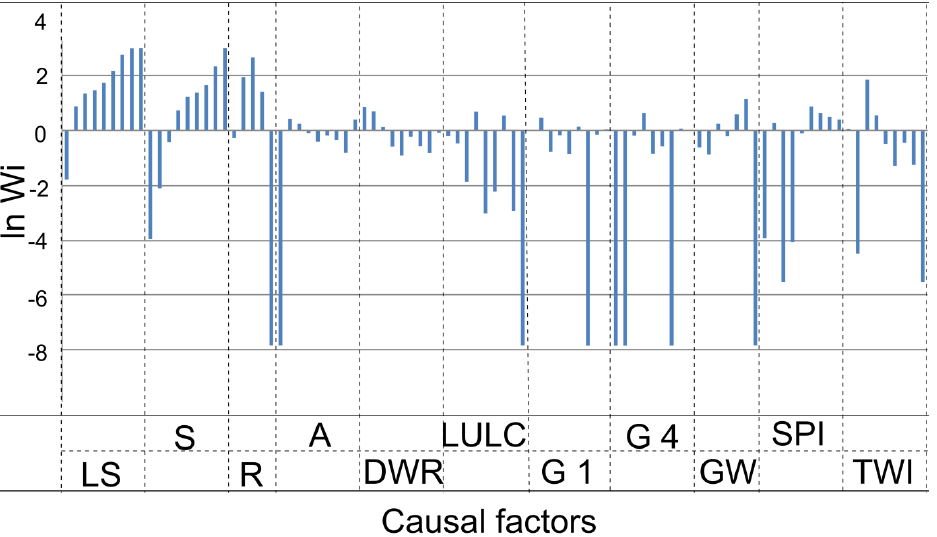
Figure 8. Importance of the conditioning factors for all landslides by the landslide susceptibility index (LSI) for entire landslide area in Gda ń sk.